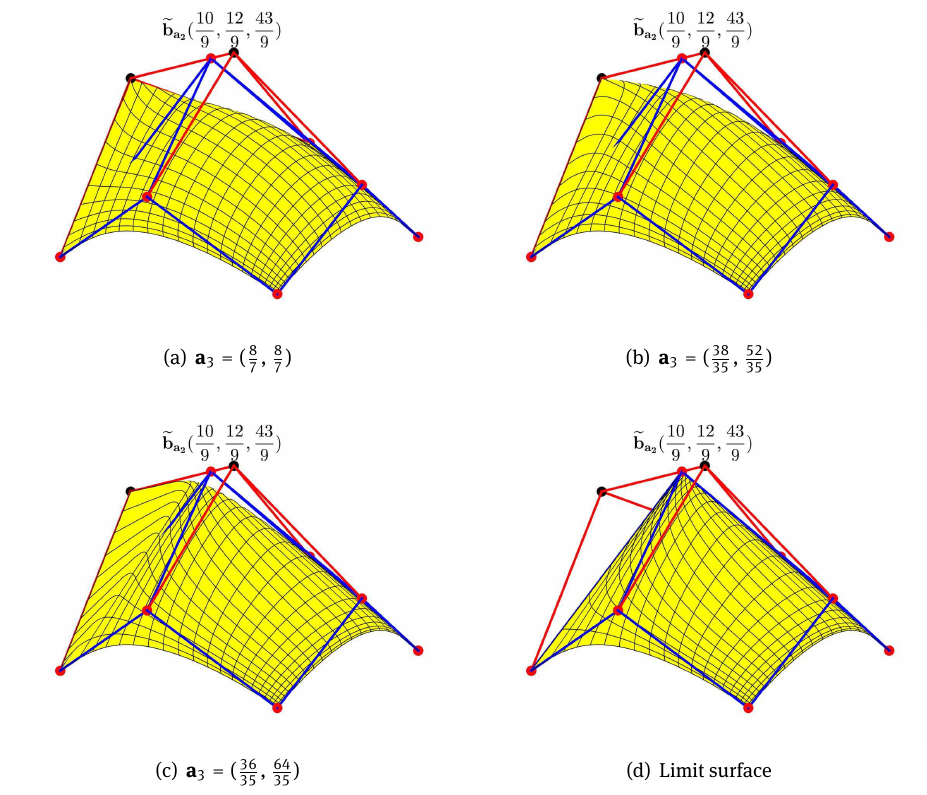
Figure 14: Limit of GT-Bézier surface with a 3 → a 1